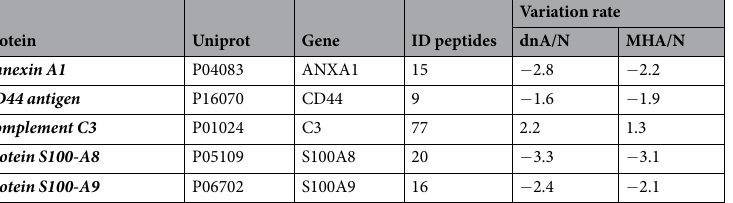
Table 2. Proteins with significant variation in urine by iTRAQ analysis in hypertensives under chronic RAS suppression developing albuminuria. Variation rate is expressed as the difference in average Zq values between groups, for the two comparisons (dnA/N and MHA/N). Zq values: log2-ratios expressed in form of the standardized variables. N: Normoalbuminuria; dnA: de novo albuminuria; MHA: maintained high